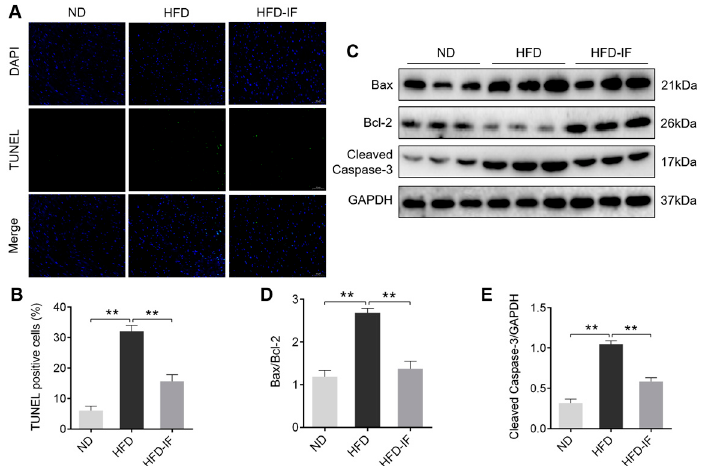
Figure 5. IF inhibits cardiac apoptosis in HFD-fed mice. ( A ) Representative images of TUNEL staining cardiac sections. The positive apoptotic particles in green and DAPI in blue. Scale bar = 50 µ m. ( B ) Quantitative analysis of TUNEL-positive cells. ( C – E ) Western blot images and their densitometric quantitative analysis of Bax/Bcl-2 ratio and Cleaved Caspase-3. Data are shown as means ± SEM. ** p < 0.01.